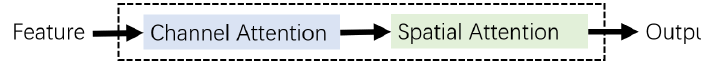
Figure 4. The Channel-Spatial Attention